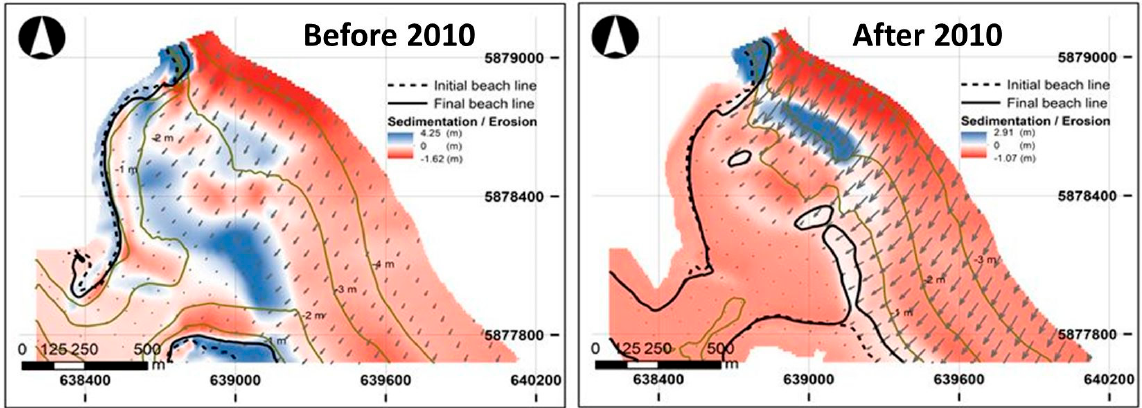
Figure 14. Morphological response of Tubul Beach before and after the 2010 earthquake for storm wave conditions.